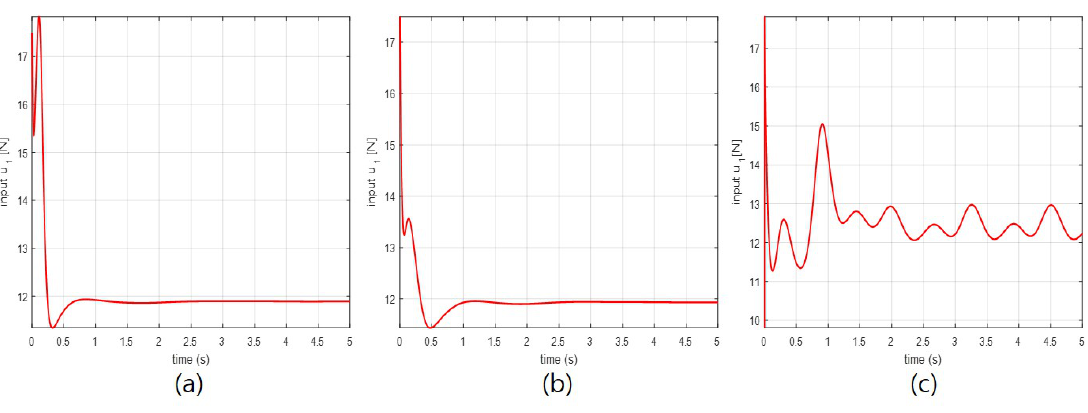
Figure 15. The control input for the altitude of a quadrotor: ( a ) Inverse optimal control; ( b ) LQR control; ( c ) PD